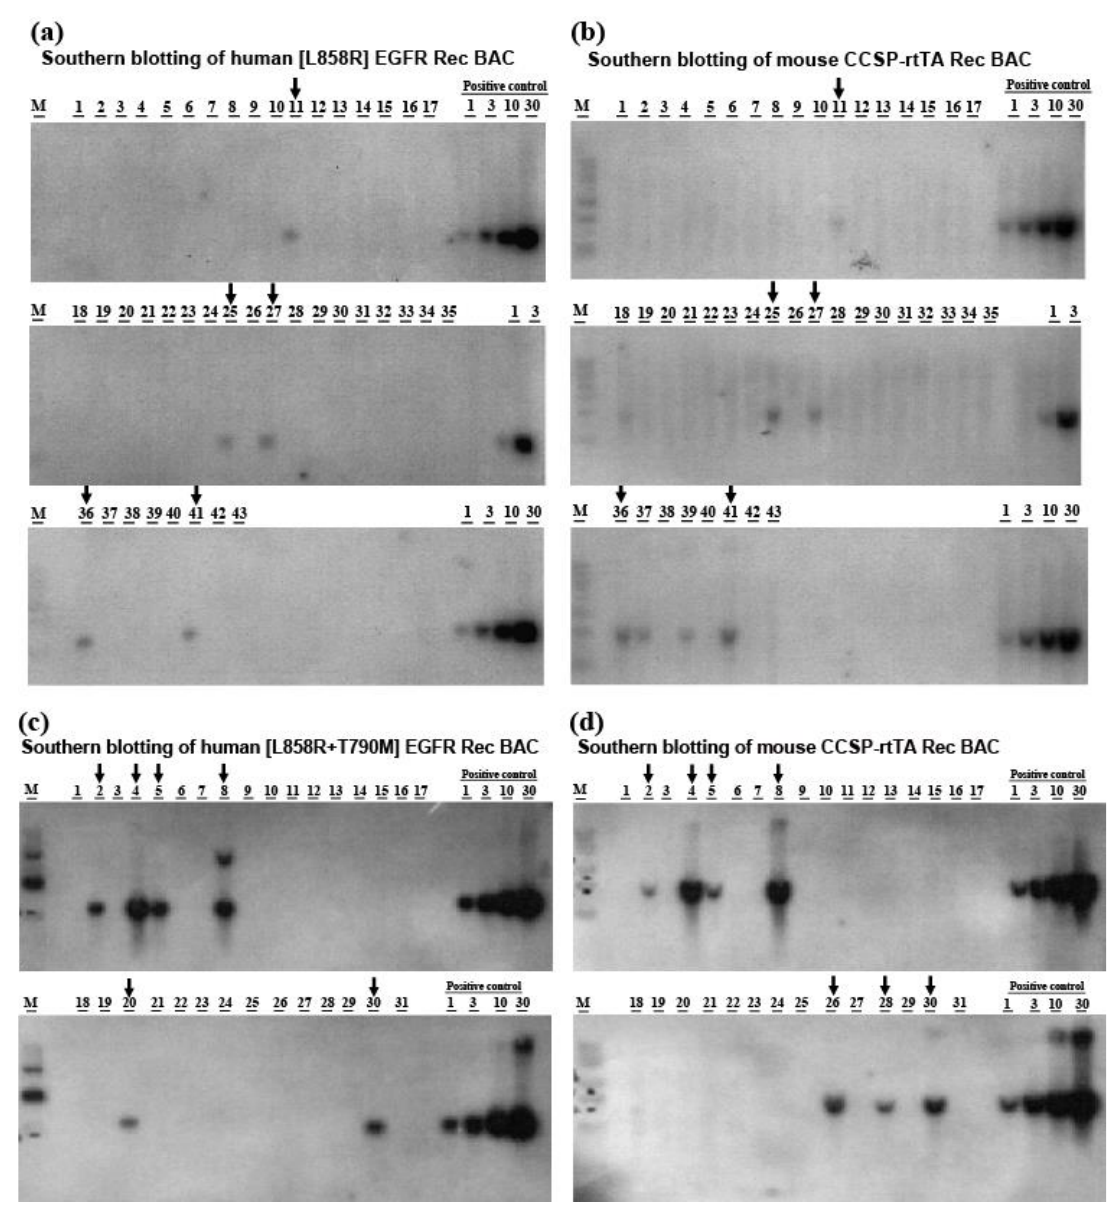
Figure 1. Founder mice expressing the full-length of human mutant EGFR and CCSP-rtTA. ( a – d ) The tail DNA from bitransgenic founder lines were analyzed by Southern blotting. The copy number of the transgenes was determined by comparing it with the control for copy number intensity.